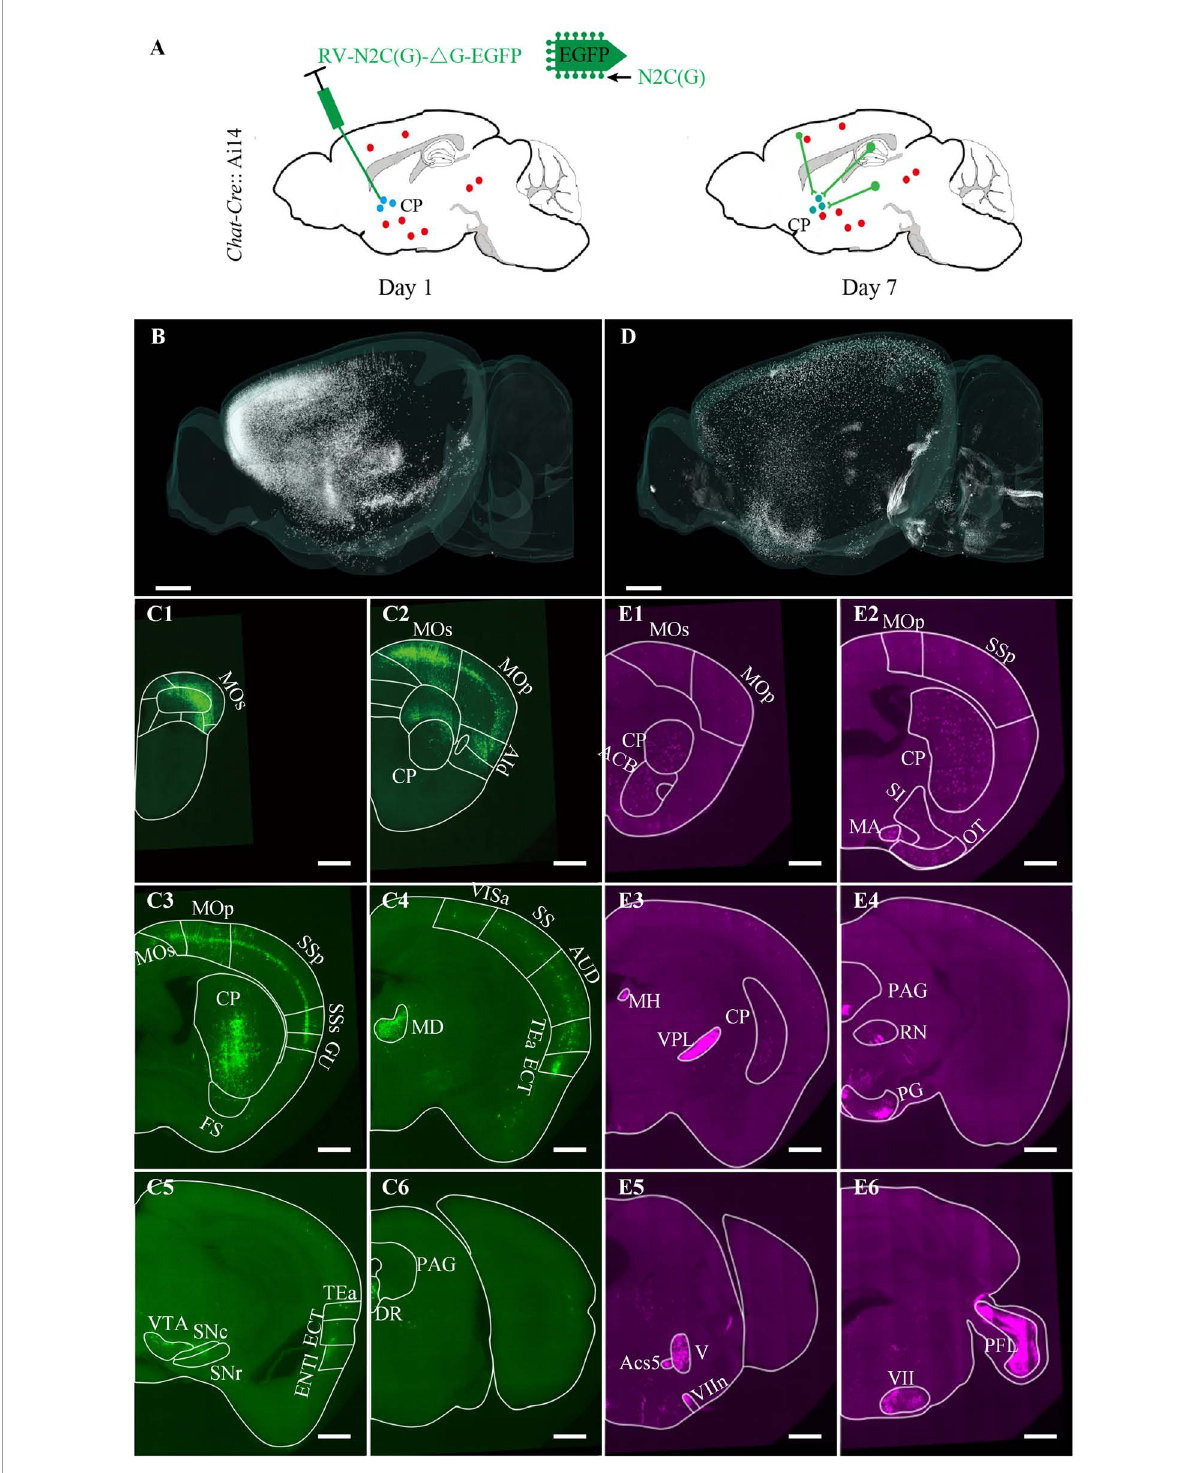
FIGURE4 Brain-wide distribution of the cholinergic neurons and the inputs of the ventral CP. (A) Labeling schematic of the inputs of the ventral CP in Chat-Cre : Ai14 transgenic mouse. (B) Brain-wide signal distribution in the green channel. (C1–C6) Representative signal distribution in the green channel at typical coronal planes. (D) Brain-wide signal distribution in the red channel. (E1–E6) Representative signal distribution in the red channel at typical coronal planes. Typical brain regions of interest were marked. The projection thickness of the images: (C1–C6) 10 µ m, (E1–E6) 40 µ m. Scale bars: (B,D) 1 mm, and (C1–C6,E1–E6) 500 µ